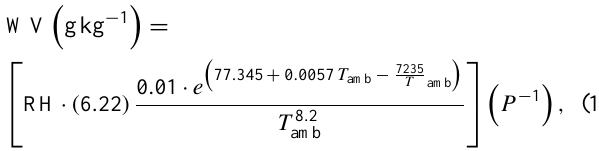
Periods of (m) measurement/model